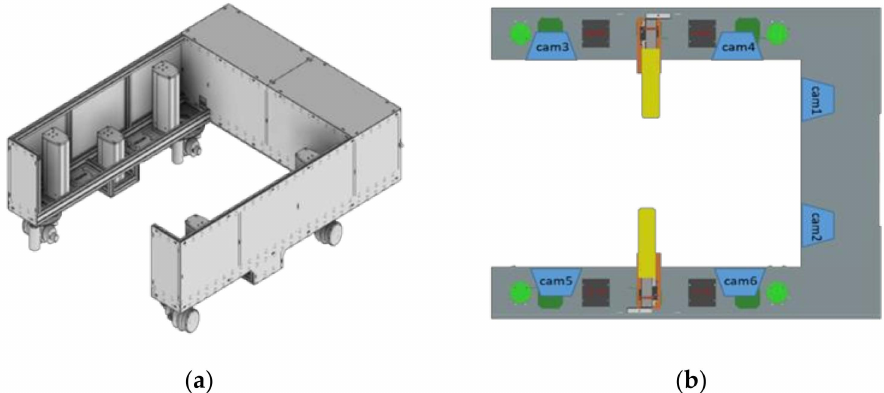
Figure 2. Mobile station and cameras. ( a ) the structure of the proposed mobile station, ( b ) the location of the camera that is attached and withdrawn from the mobile